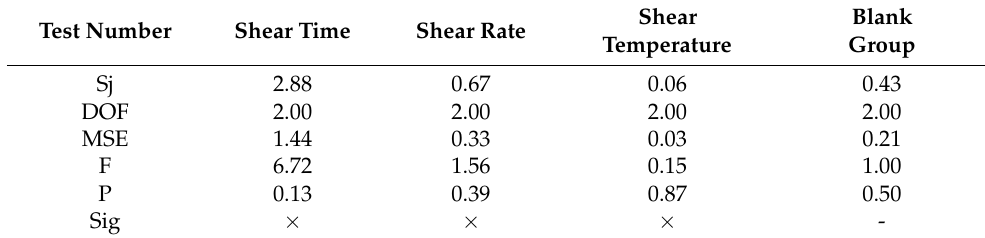
Table 12. Ductility variance